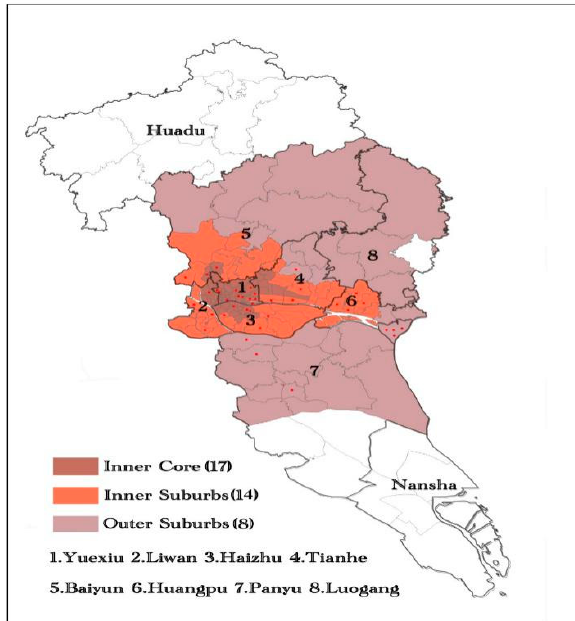
Figure 1. Distribution of surveyed communities.